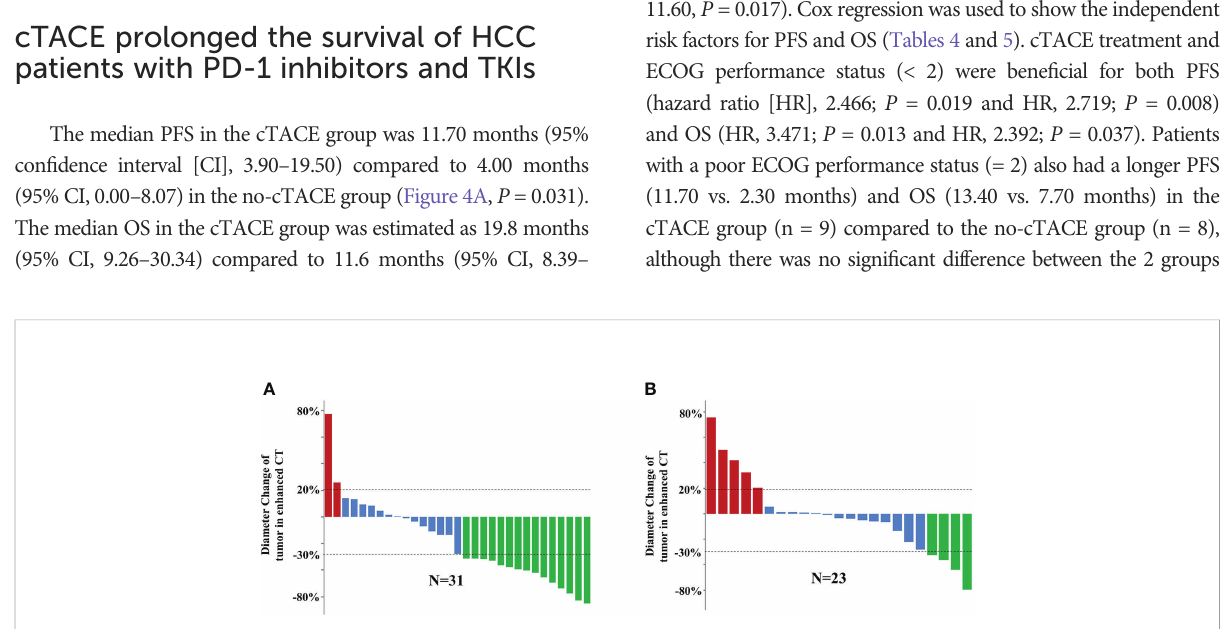
(Figure S1, mPFS was 16.40 vs. 3.70, P = 0.028; mOS was 21.00 vs. 11.60, P = 0.017). Cox regression was used to show the independent